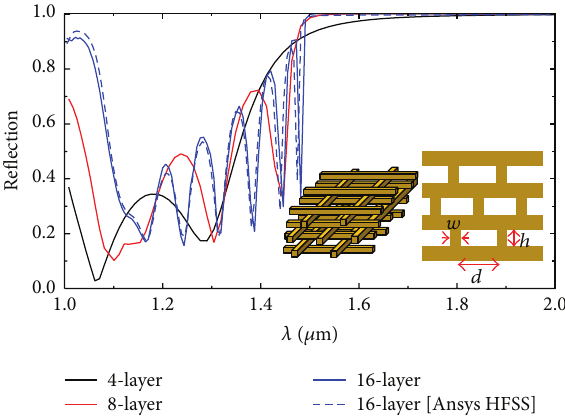
Figure 7: Reflection spectra for multilayered woodpile MPC.